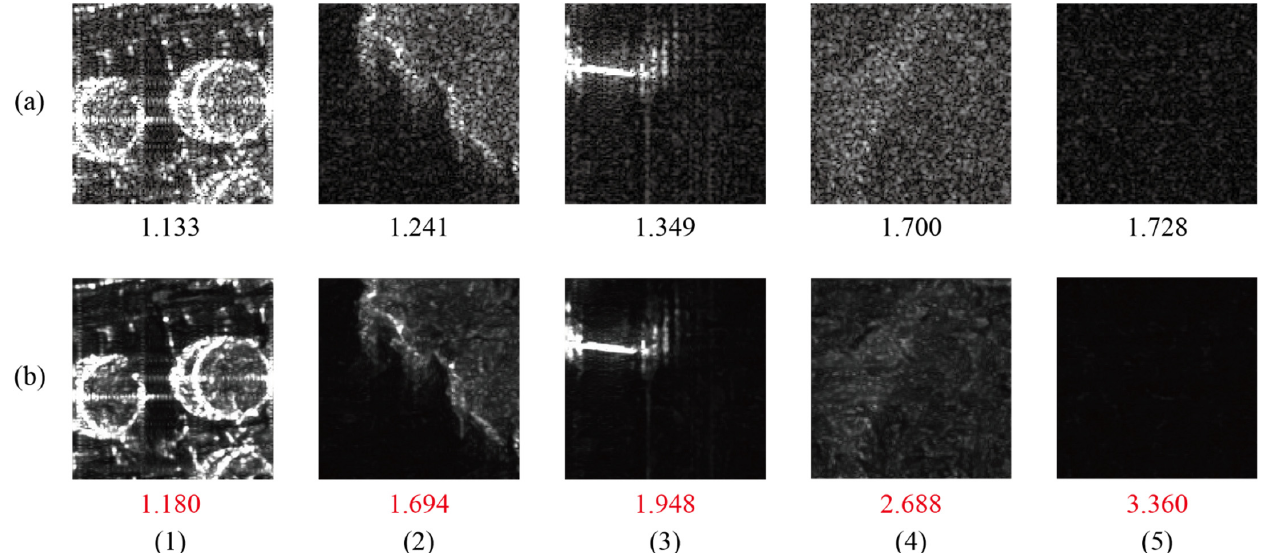
Figure 9. The despeckling results for noise of different intensities. ( a ) the input images with noise of different intensities. ( b ) images processed by the proposed method. (1) to (5) represent the examples with the noise of different intensities. The scores below the images are ENLs. The red format represents the best scores.